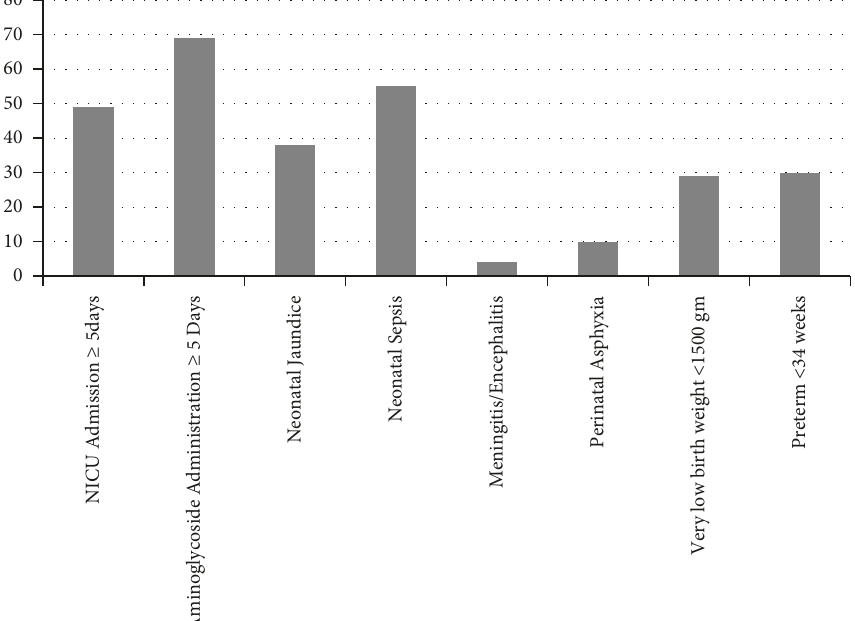
Figure 2: Bar chart frequency of risk factor assessment of newborns (5). Table 1: The refer rate of newborns according to gestational age and birth weight (5). Factors Number of newborns Pass TEOAE